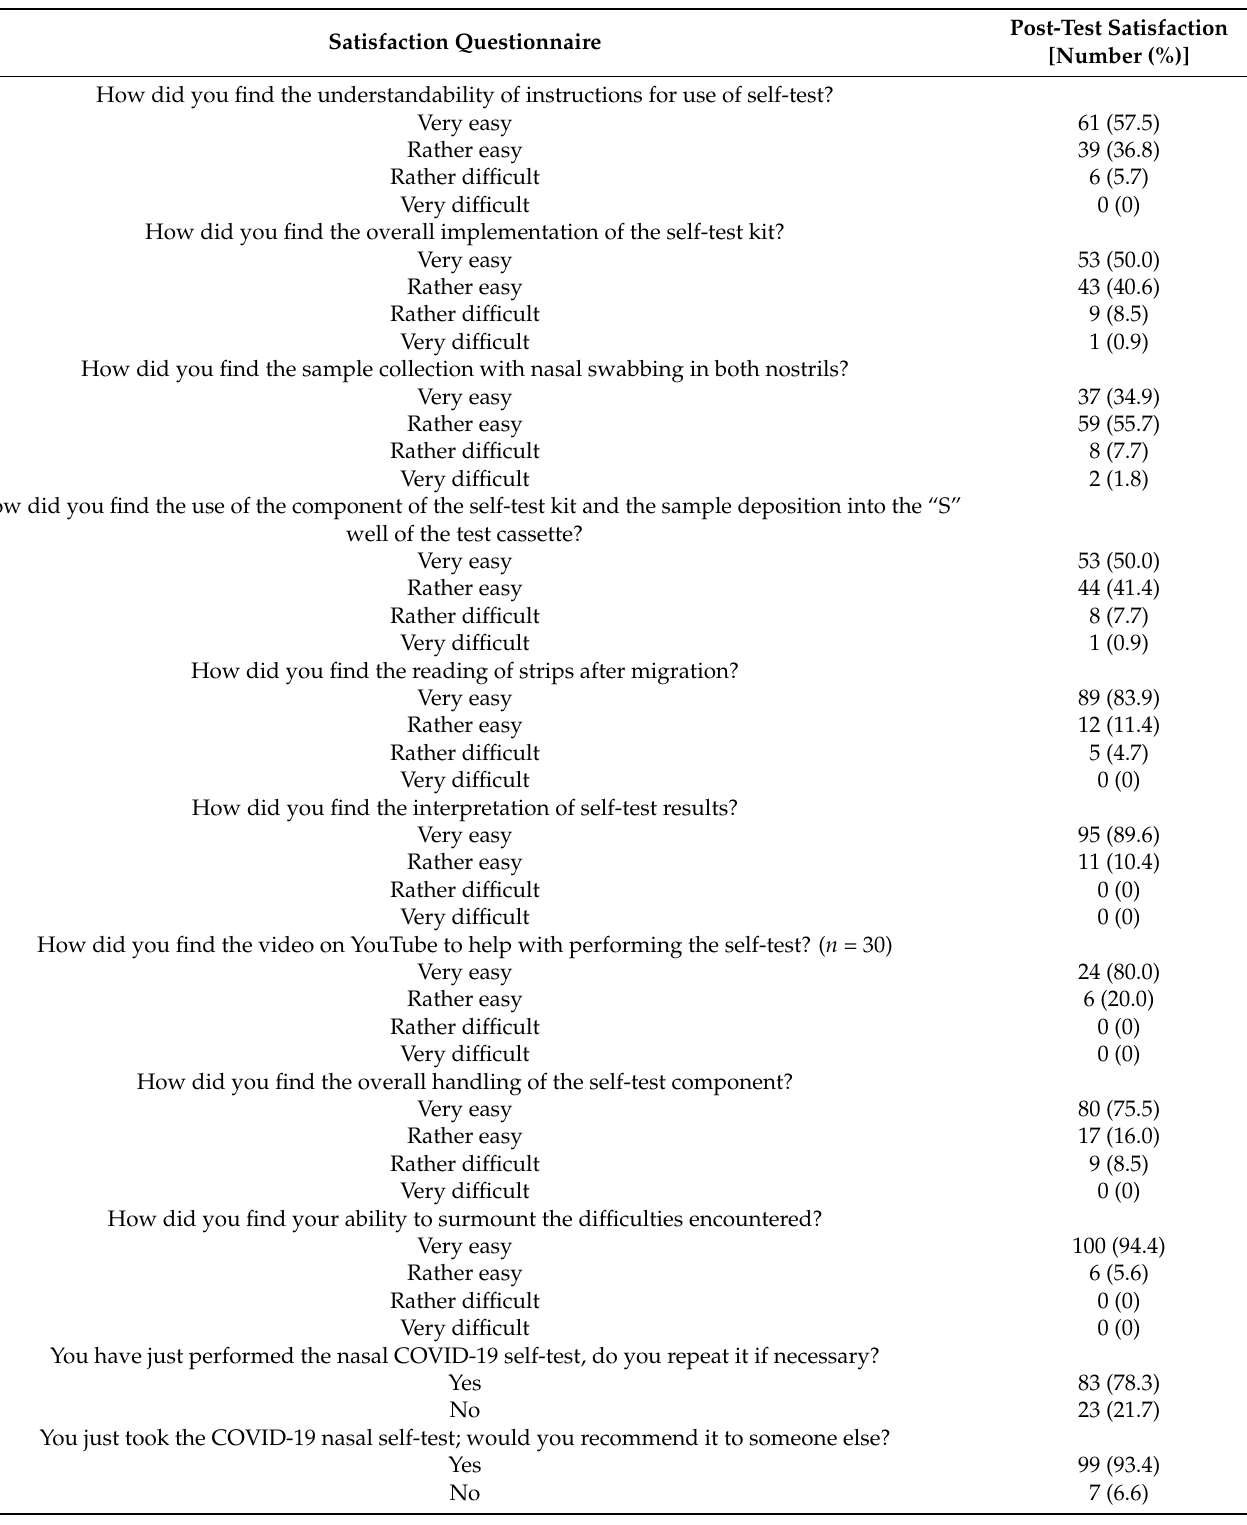
Table 4. Items and results of the satisfaction questionnaire and concerning the instruction notice (sub-study 1), the performing of the BIOSYNEX Antigen Self-Test COVID-19 Ag+ (Biosynex Swiss SA) (sub-study 2), and the interpretation of test